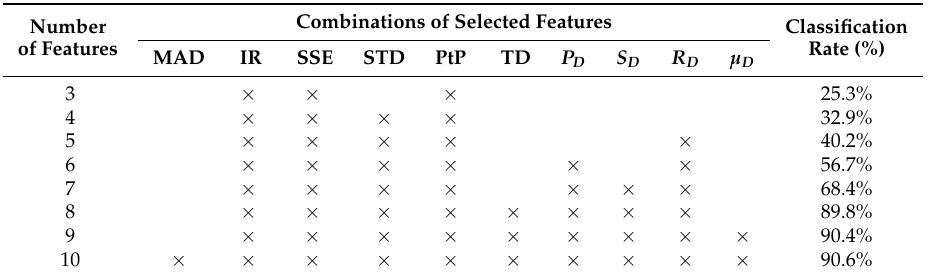
Table 4. Classification by taking away one feature at one